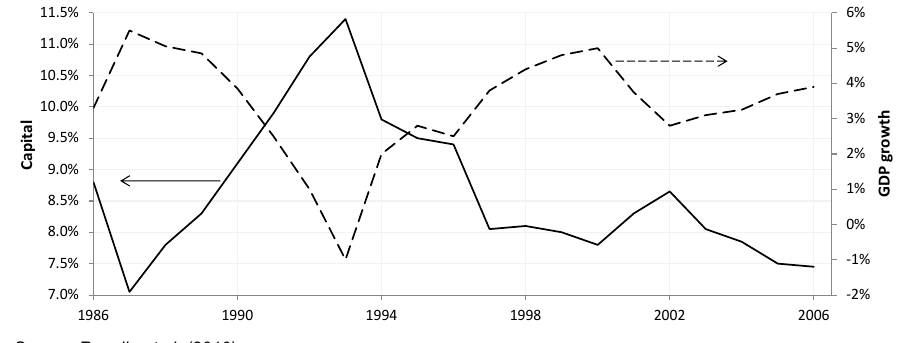
The negative correlation between Basel requirements and the business cycle for Spanish